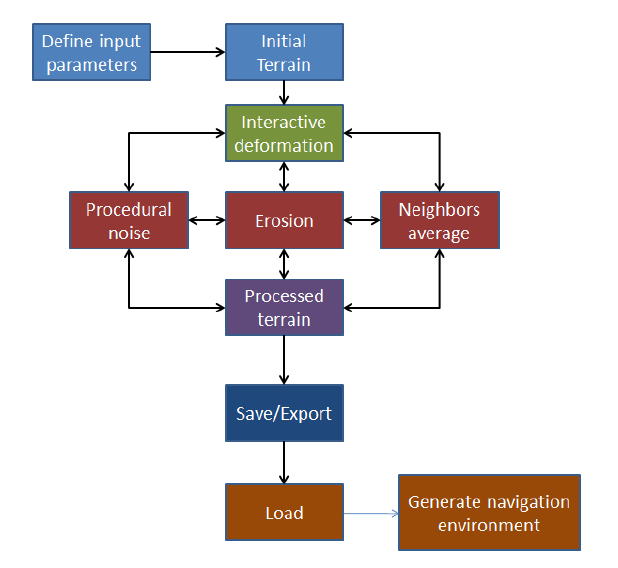
V. S YSTEM U SAGE